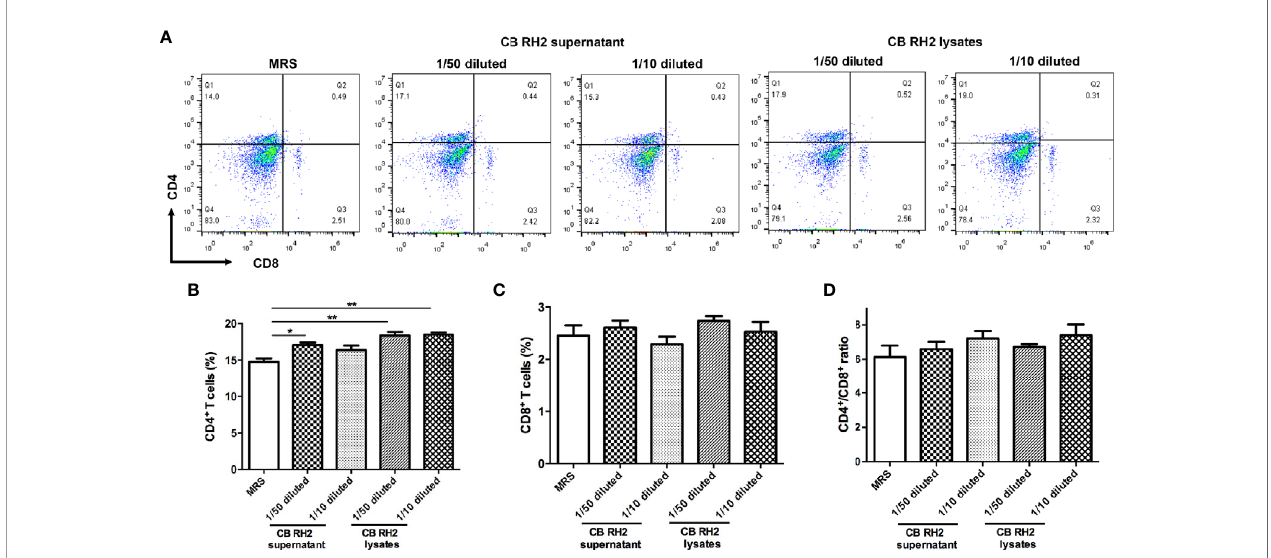
FIGURE 6 | CB RH2 and its metabolites promote expansion of CD4 + T cells. (A) Representative fl ow cytometry plots; (B, C) Percentage of CD4 + and CD8 + T cells in Payer ’ s patches (PPs) of mice post stimulation of the supernatant and lysate of CB RH2; (D) The proportion of CD4 + /CD8 + . The MRS medium was used as control. All data were evaluated as mean ± SEM (n = 3), *p <0.05, **p